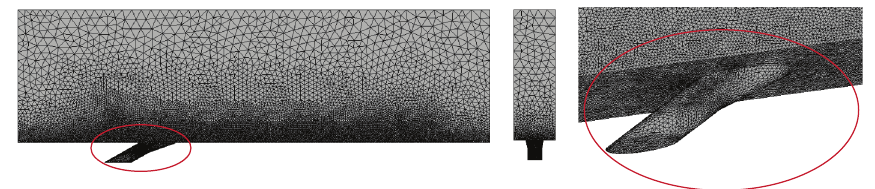
Figure 8: Unstructured grid used for the LFDSA-5-5 hole with a minimum cell size of 0.4 mm and a maximum cell size of 2.4mm.